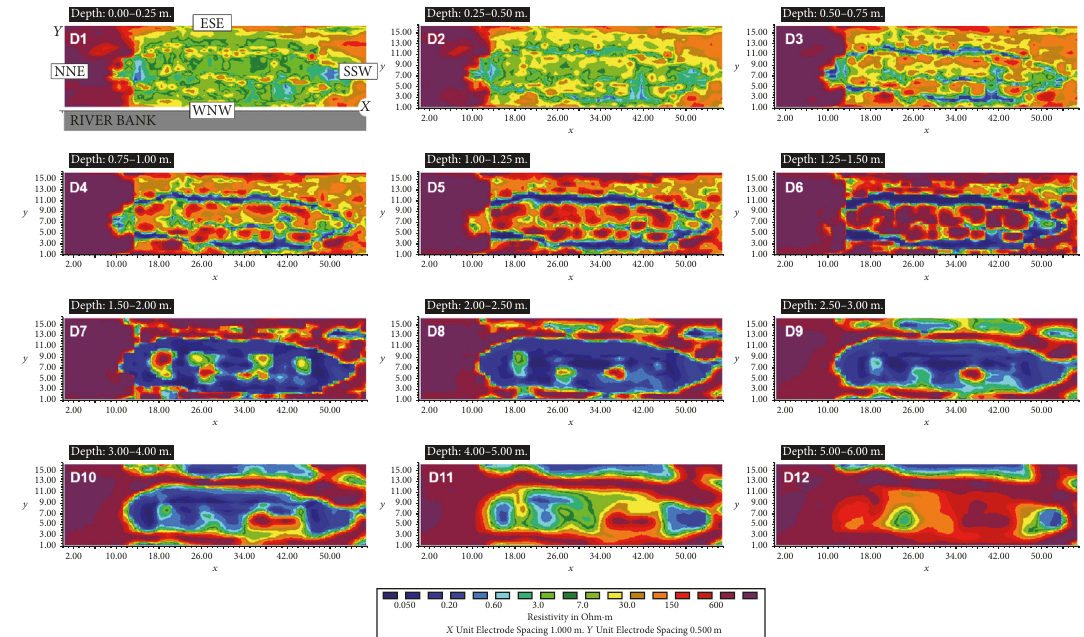
Figure 10: 3D inversion depth slices. Resistivity values mapped on a logarithmic scale. Both axes are given in meters.